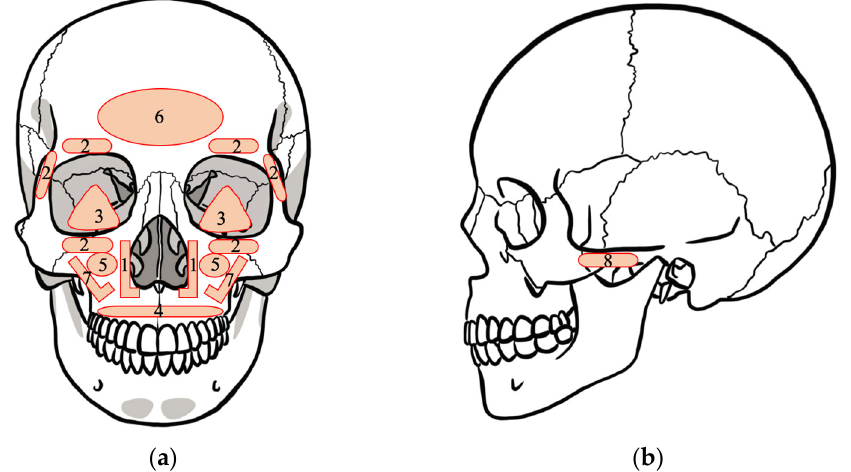
Figure 3. Schema of the position where the plate is placed: ( a ) coronal section of skull; ( b ) sagittal section of skull. The label numbers on the skull refer to: (1) pyriform aperture, (2) periorbita, (3) orbital floor, (4) alveolar bone, (5) maxillary sinus anterior wall, (6) frontal bone, (7) infra zygomatic crest, and (8) zygomatic arch.